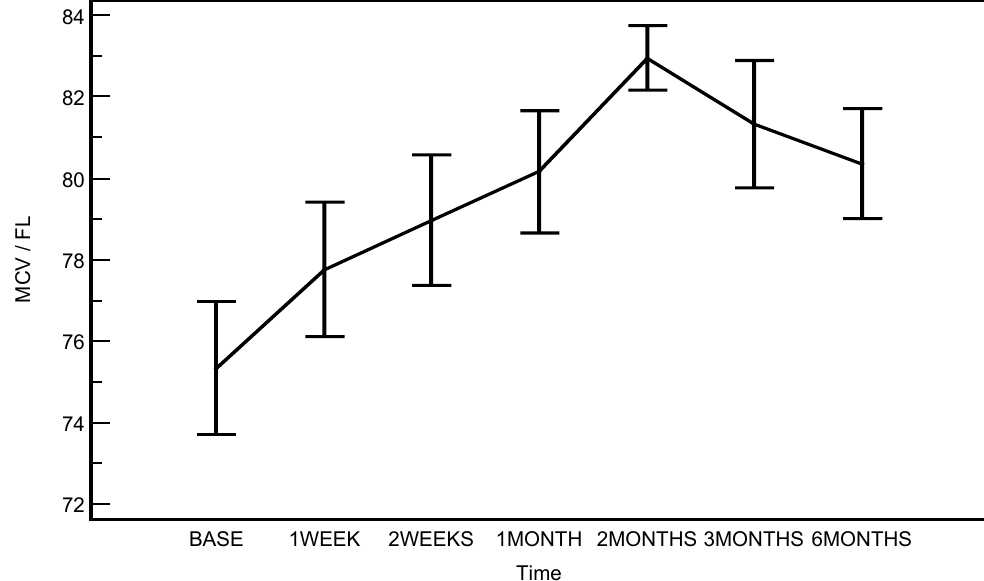
FIGURE 5. Increase in red blood cell MCV following infusion of the RSC into patients with beta-thalassemia. Artificial values at baseline due to recent